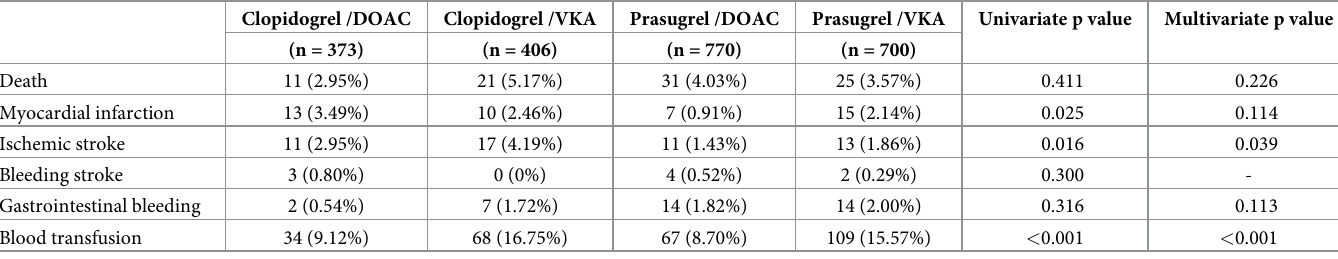
Table 4. Clinical events in AMI patients.